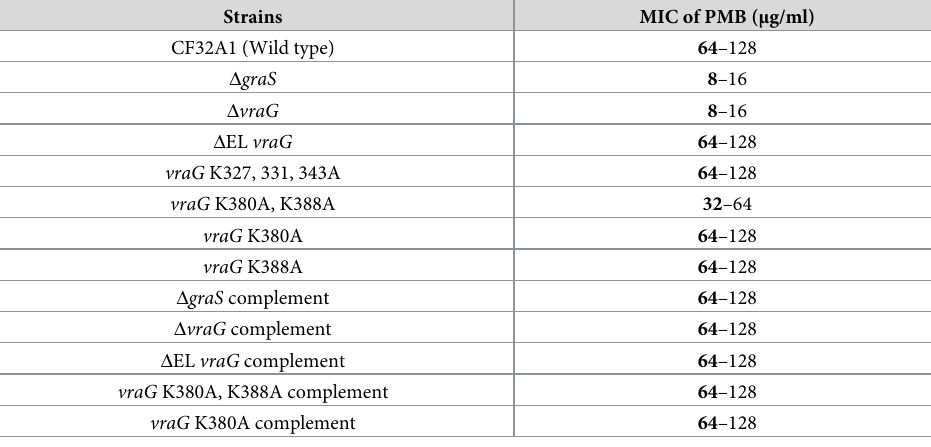
The bold numbers indicate median values from at least three biological